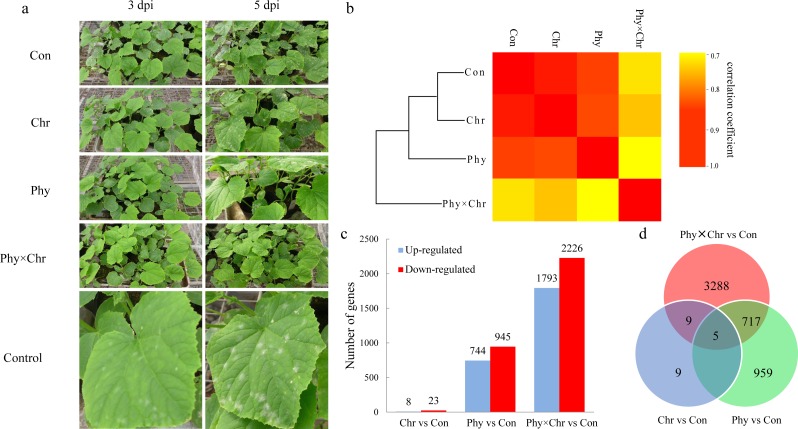
The global transcriptome similarity and differences caused by physcion and chrysophanol treatment for cucumber powdery mildew.(A) Histological investigation of leaves inoculated with S. fuliginea at 3 dpi and 5 dpi after the four treatments. (B) Hierarchical clustering and heat map matrix of pairwise Pearson’s correlations of the expression profiles in leaves between the four treatments (solvent-treated control; chrysophanol treatment; physcion treatment; physcion and chrysophanol combination treatment) (log2-fold changes). (C) The up- and down-regulated DEGs. (D) A Venn diagram displaying the distribution of the DEGs.